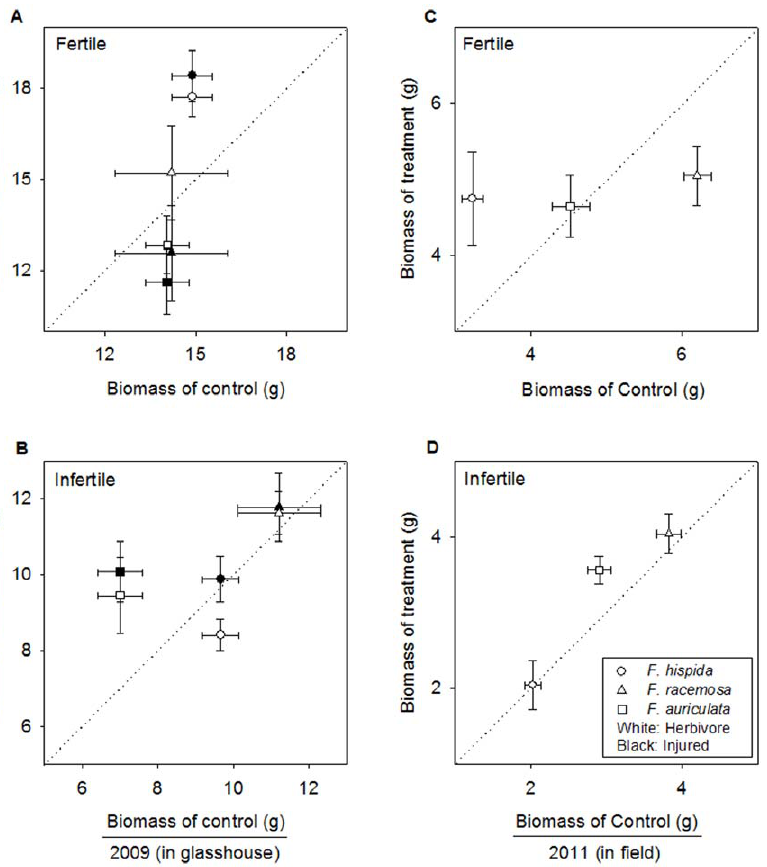
Figure 2. Compensatory growth of three Ficus species in response to herbivore treatment. Plant biomass above the line indicates overcompensatory regrowth, on the line indicates fullcompensatory regrowth, below the line indicates undercompensatory regrowth (Biomass in the damaged state = biomass in control state, slope =1) (n=5 in 2009, n=12 in 2011).